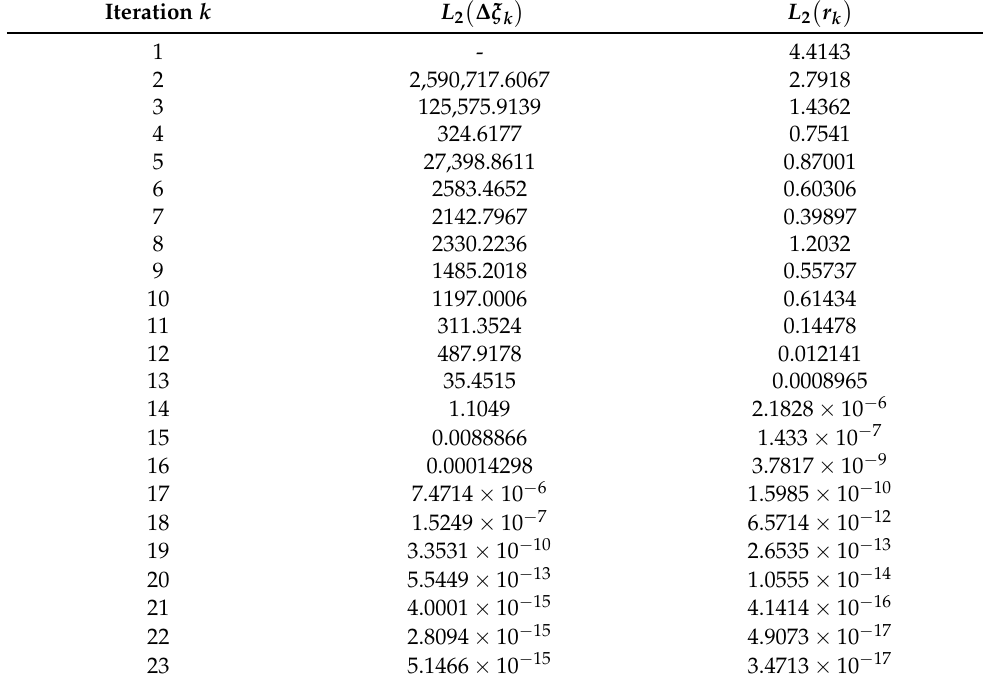
Table 2. Moëbius strip: convergence L 2 norms terms used in the least-squares